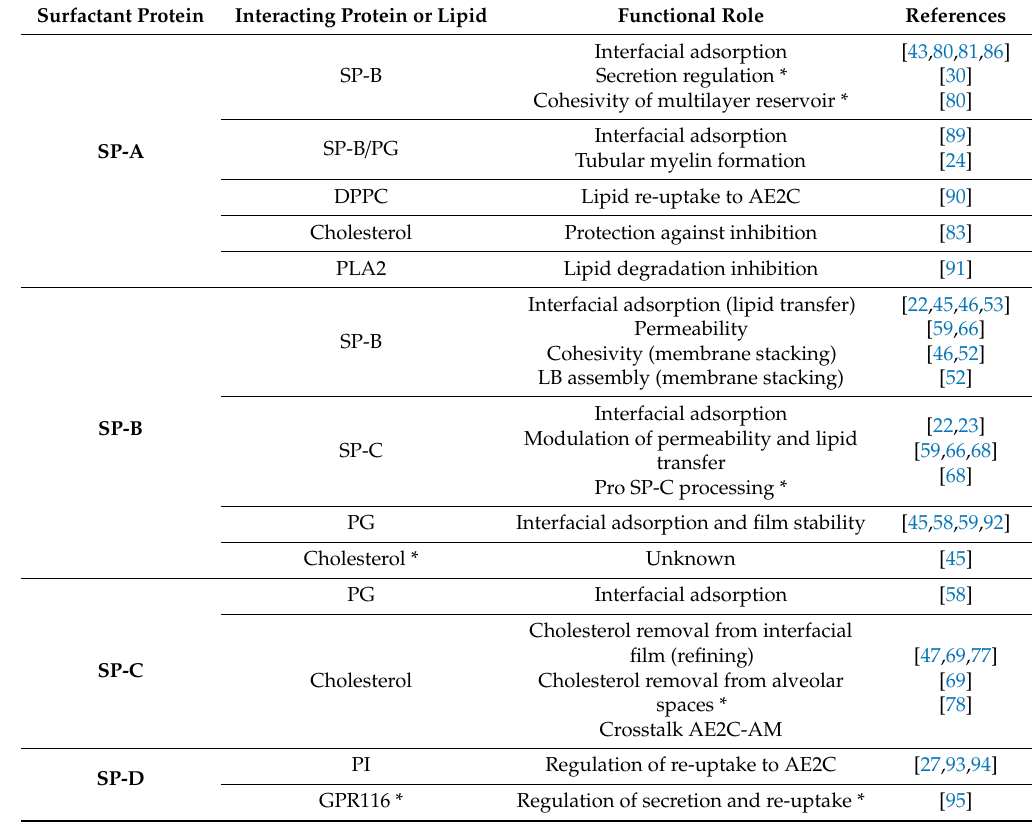
Table 1. Summary of protein / protein and protein / lipid interactions involved in alveolar homeostasis through regulation of surfactant film formation and stability, as well as surfactant levels in alveolar